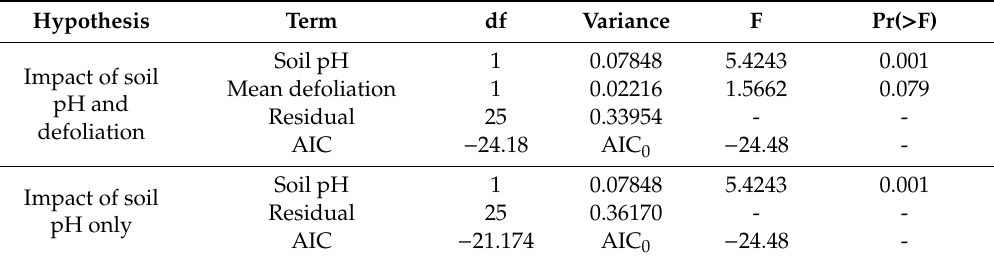
Table 5. PERMANOVA test of the influence of soil pH and mean defoliation on understory vegetation species composition in redundancy analysis (RDA) in a reduced space (Figure 3). AIC 0 refers to the null model (unconstrained analysis). AIC, Akaike information criterion.